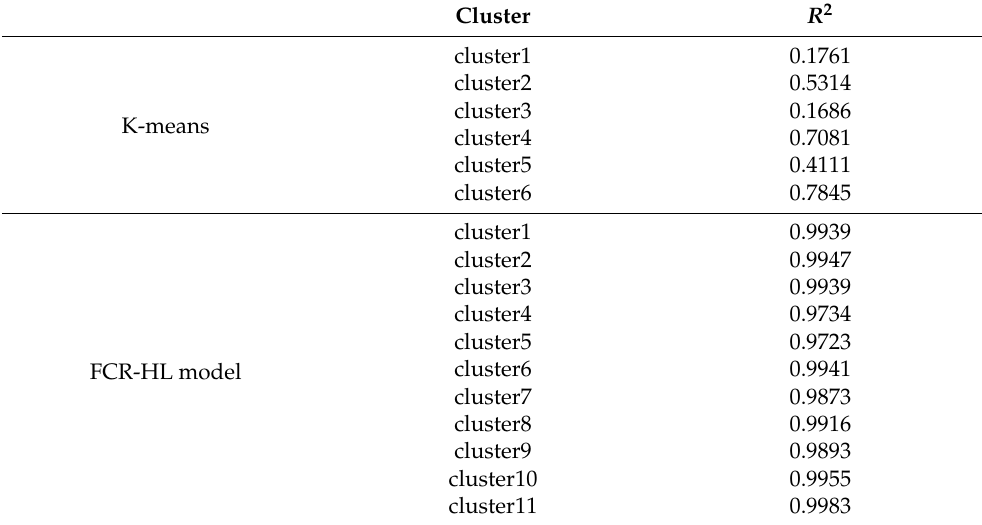
Table 6. The performance of the R 2 of the K-means method and FCR-HL model. Cluster R